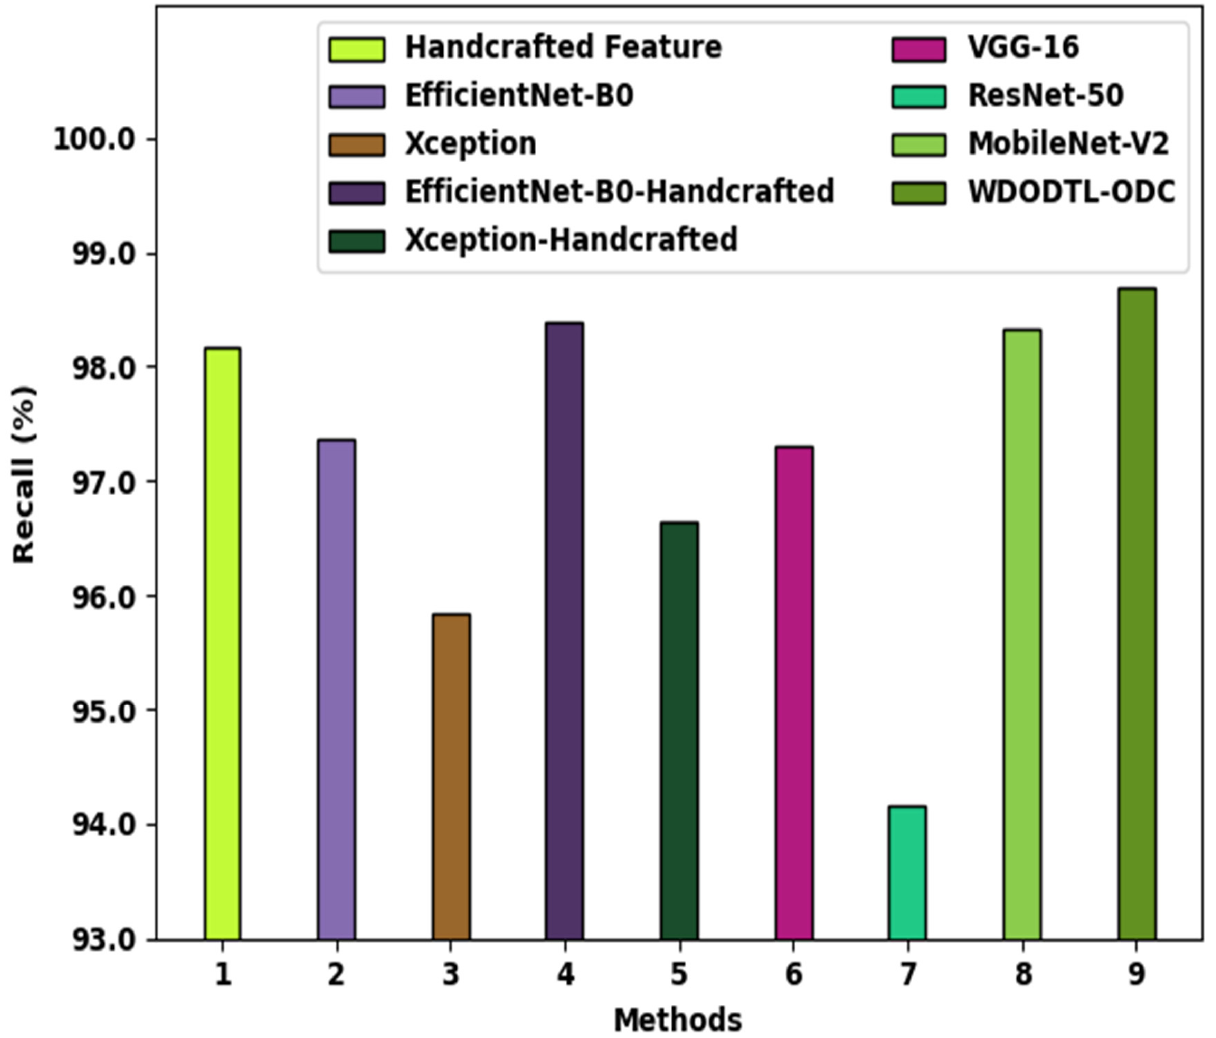
Figure 11. Reca l analysis of WDODTL-ODC approach with existing Figure 11. 𝑅𝑒𝑐𝑎 (cid:3039) analysis of WDODTL-ODC approach with existing algorithms.